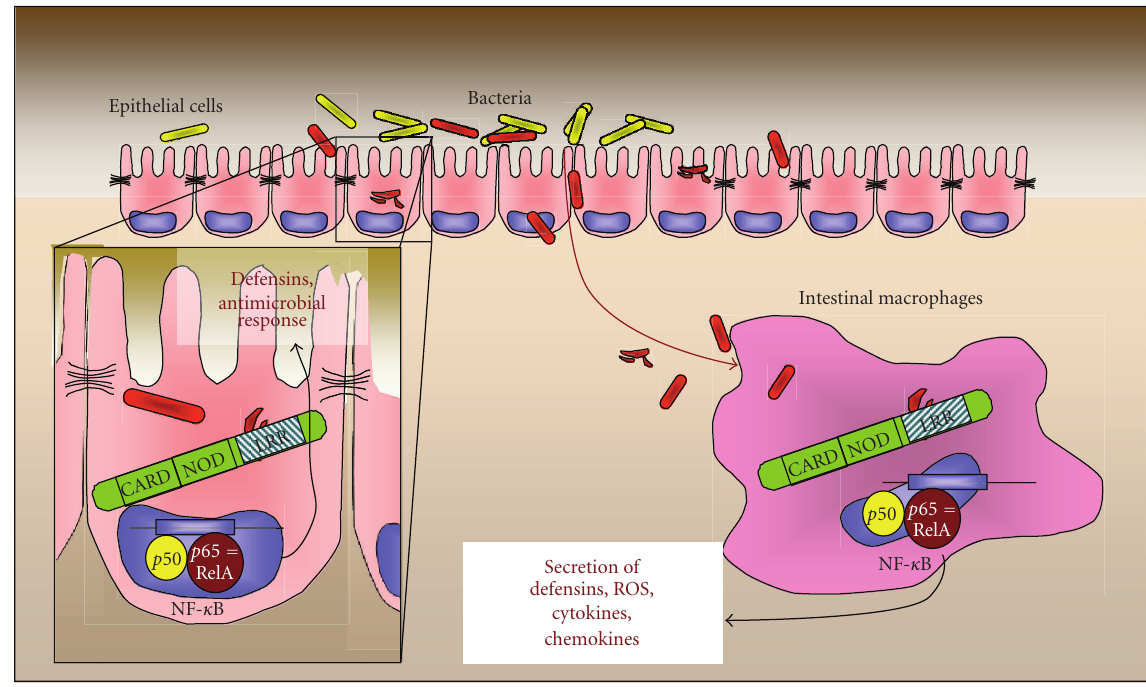
Figure 2: NOD2 and intestinal immune response. The NOD2 contains an e ff ector-binding domain (CARD), a self-oligomerization domain (NOD), and a ligand recognition domain (LRR). The three CD-associated SNPs are located within or near the LRR domain. NOD2 is primarily localised in intestinal epithelial cells and macrophages. Upon binding to its ligand, bacterial MDP, NOD activates the transcription factor NF- κ B, what mainly results in the expression of the antimicrobial defensins and various cytokines that trigger the antimicrobial